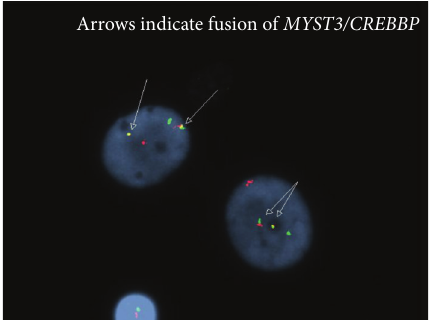
Figure 3: FISH analysis demonstrating the MYST3/CREBBP fusion. The red probe is detecting MYST3, the green probe is detecting CREBBP, and the yellow probe indicates